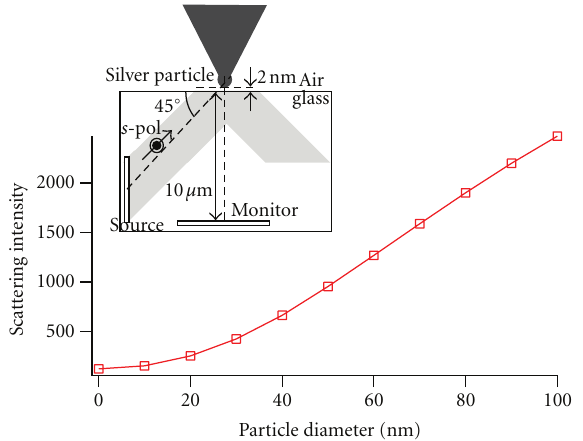
Figure 3: FDTD simulation of s -polarization scattering intensity from silver particle with respect to the apex diameter. Inset illustrates the simulation conditions.